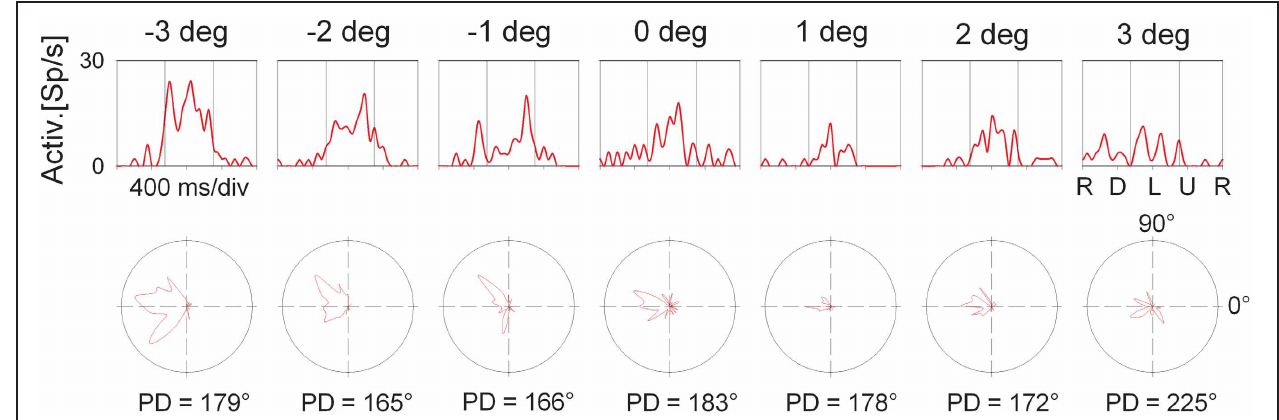
FIGURE 6 | Directional tuning as a function of disparity: single cell level. The panels in the top row shows the response (spike density function) to a complete cycle (corresponding to 1600ms) of the circular pathway stimulus of the neuron whose average discharge for the preferred direction is shown in Figure 3 . The sequence of stimulus directions is shown on the very right: